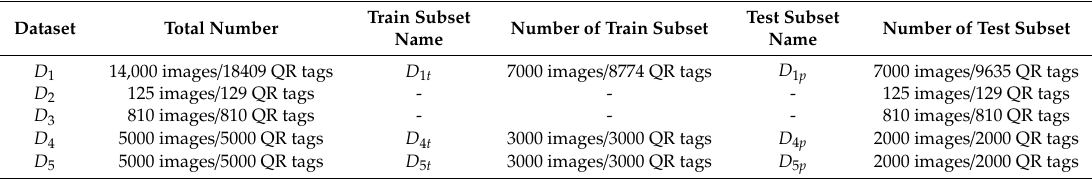
Table 4. The datasets used in this article.